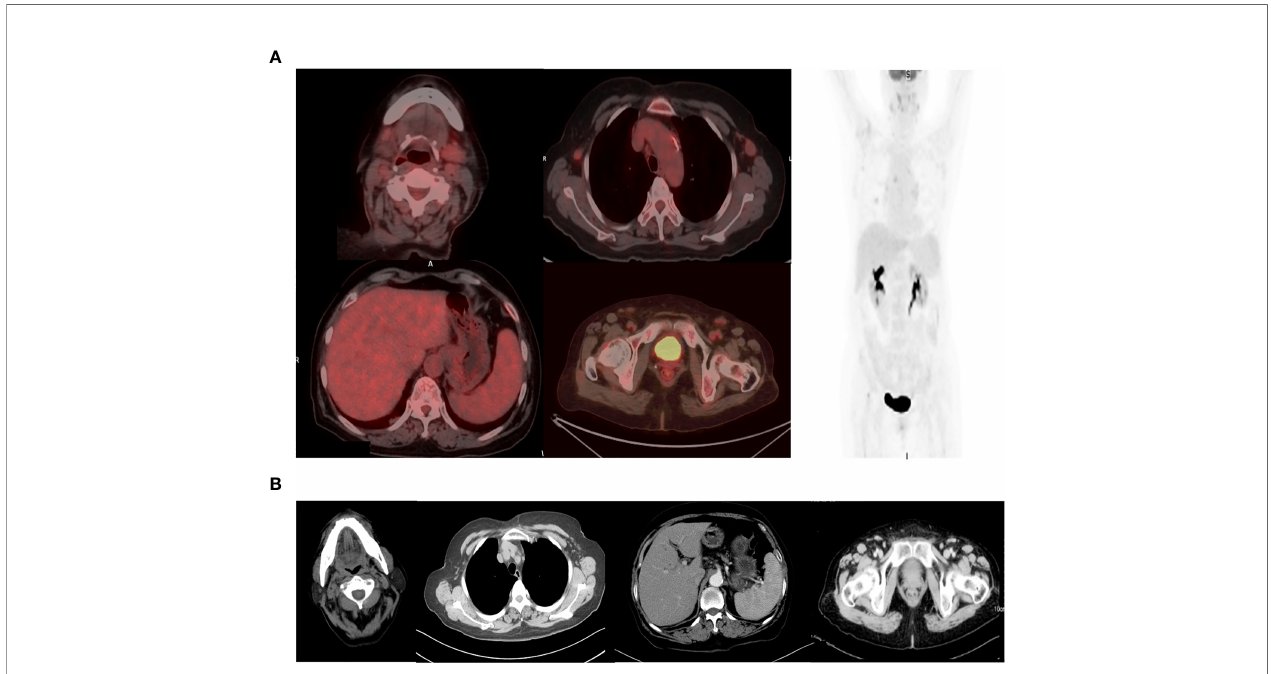
FIGURE 3 | The fi nal PET – CT and enhanced CT evaluation of the patient. (A) The fi nal PET – CT evaluation showed complete metabolism remission after eight cycles of tislelizumab and lenalidomide. (B) The enhanced CT evaluation showed complete remission 4 months after PET